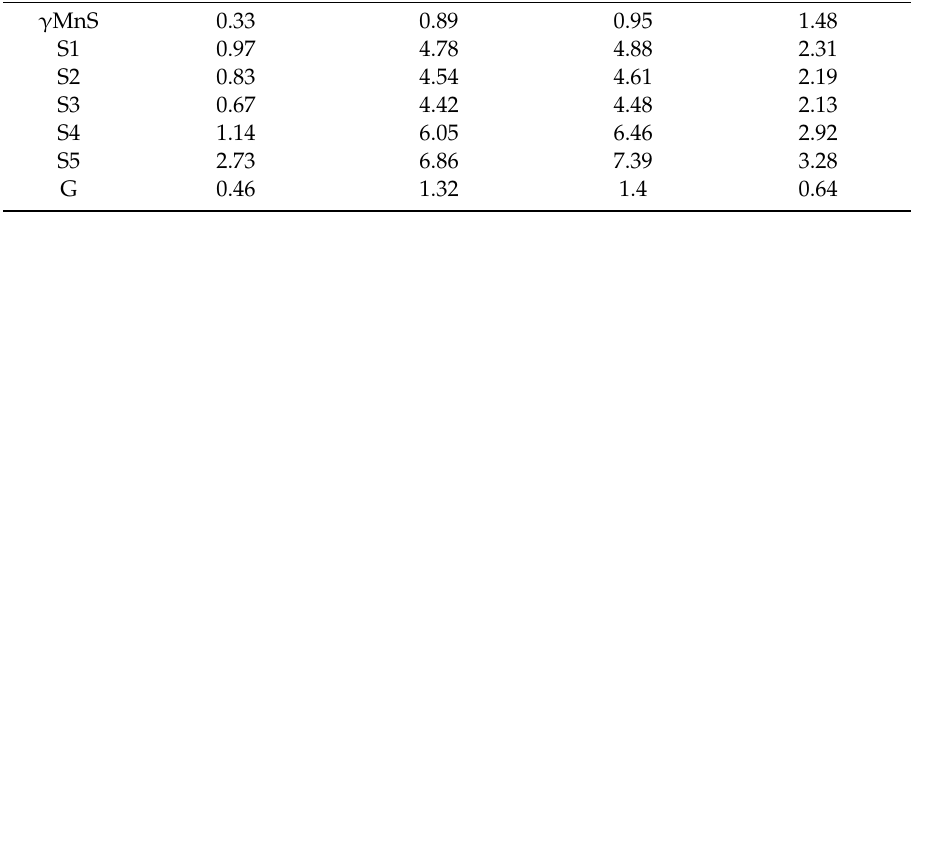
Table 2. The nonlinear optical parameters of S1, S2, S3, S4, S5.